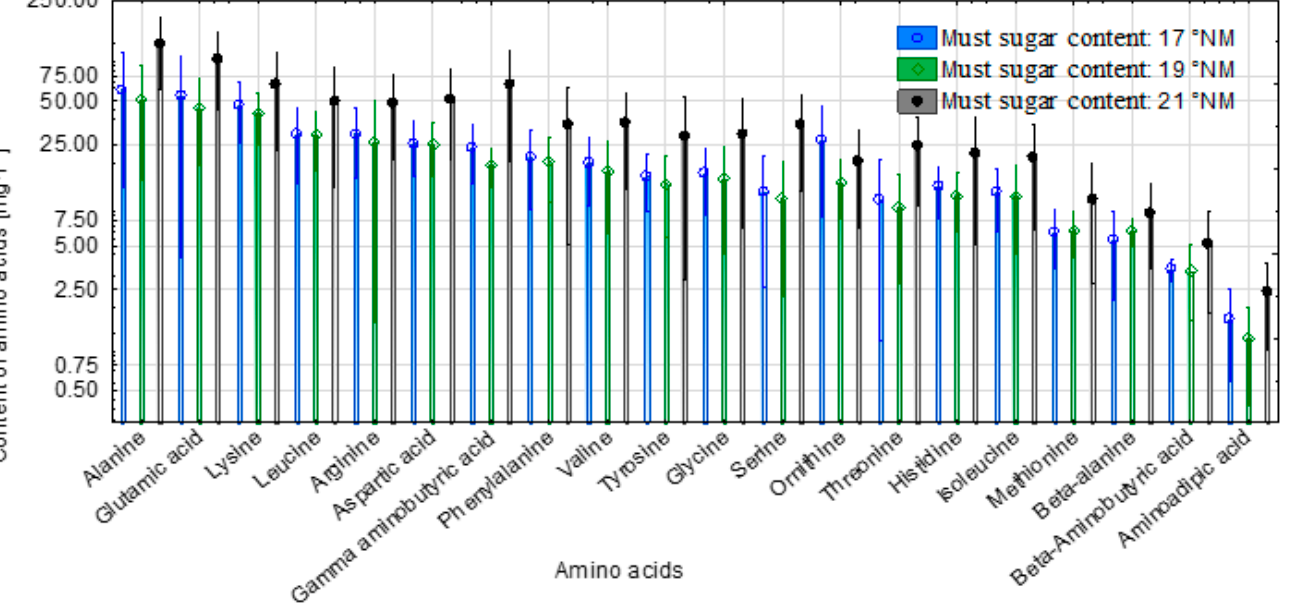
Figure 4. Comparison of average amino-acid content by must sugar content.